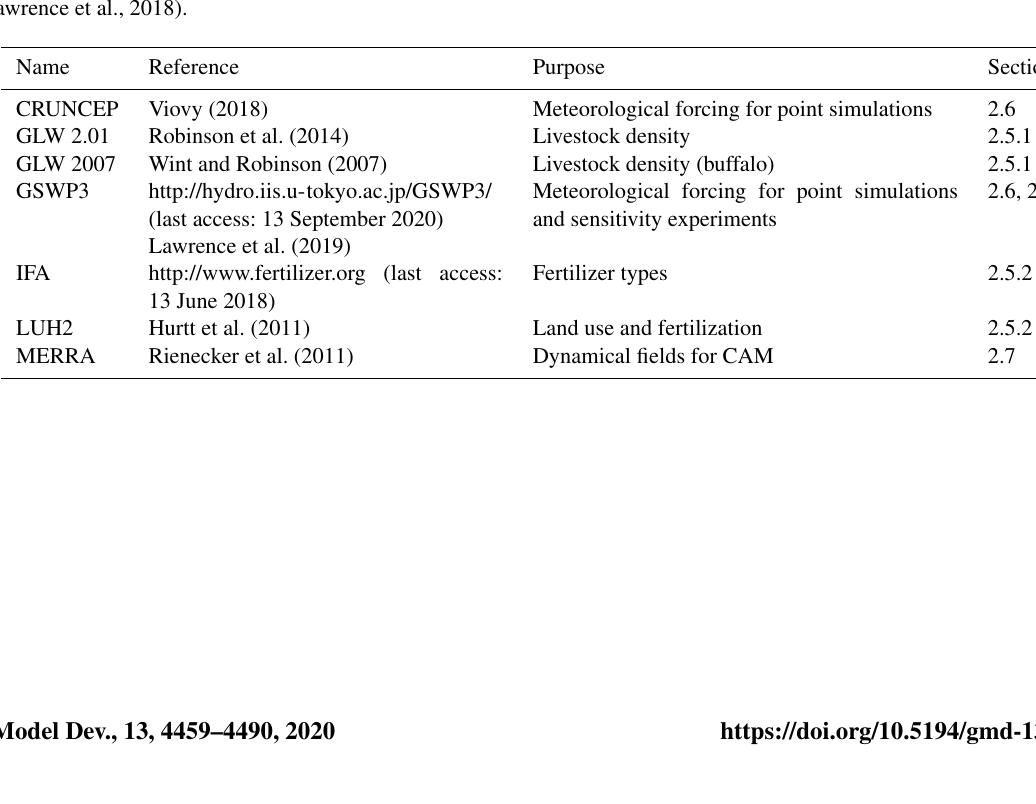
Table B2. Main datasets used in this study. In addition, the simulations use the standard input datasets of CAM4 (Lamarque et al., 2012) and CLM5 (Lawrence et al.,